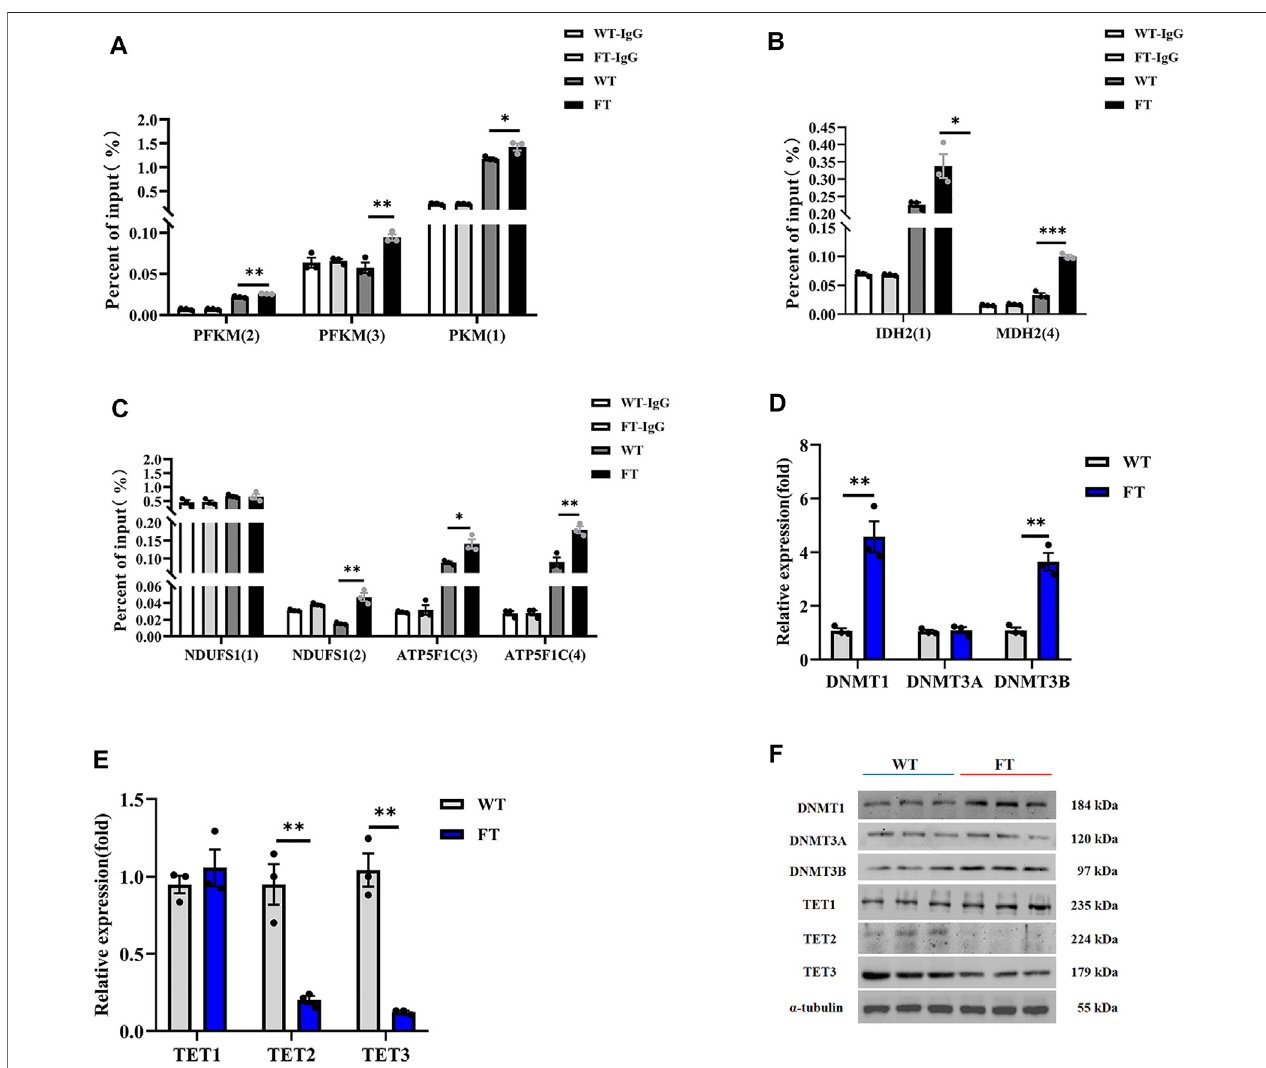
FIGURE4| Effect ofDNAmethylation onrate-limiting enzymes related toenergy metabolism. (A – C) Methylationlevels inpromoters ofgenesassociatedwithrate- limitingenzymesinglycolysis (A) ,TCAcycle (B) ,andOXPHOS (C) ( n =3).TheCpGislandwaspredictedinthepromoterregionofthegene,andthenthepredictedCpG islandwasdetectedbyMethylatedDNAimmunoprecipitation(MeDIP)byRT-qPCR.LocationofCpGislandwasshownin SupplementaryFigureS2 . (D,E) Expression of mRNA for methyltransferases and demethyltransferases by RT-qPCR in WT and FT bEFs. ( n = 3). (F) Expression of protein for methyltransferases and demethyltransferases byimmunoprecipitation inWT and FT bEFs.Western blotsobtainedbyimmunoblotting antibodies directed against DNMT1, DNMT3A, DNMT3B, TET1,TET2andTET3.WT(blueline)vs.FT(redline).indicatesthelocationofIsland,pleasereferto SupplementaryFigureS2 fordetailedlocation.eg.,PFK(2)means PFK (Island 2). Each dot represents an independent experiment. All data are presented as mean ± SEM. Compared with the WT group, * p < 0.05, ** p < 0.01, *** p < 0.001, **** p < 0.0001; t-tests were used to calculate the p